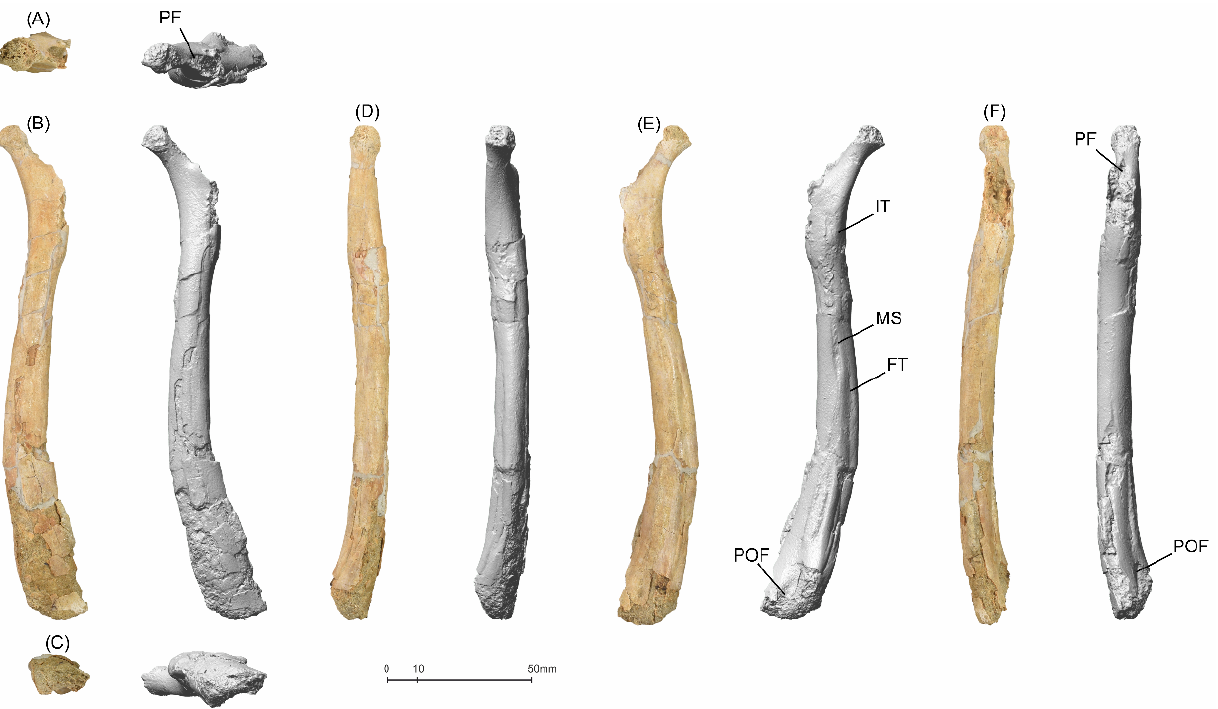
Figure 6. MGUAN-PA163 left femur. ( A ) proximal, ( B ) anterior, ( C ) distal, ( D ) medial, ( E ) posterior, and ( F ) lateral views. Abbreviations: FT, fourth trochanter scar; IT, internal trochanter; MS, muscle scar; PF, pneumatic foramina; POF, popliteal fossa.